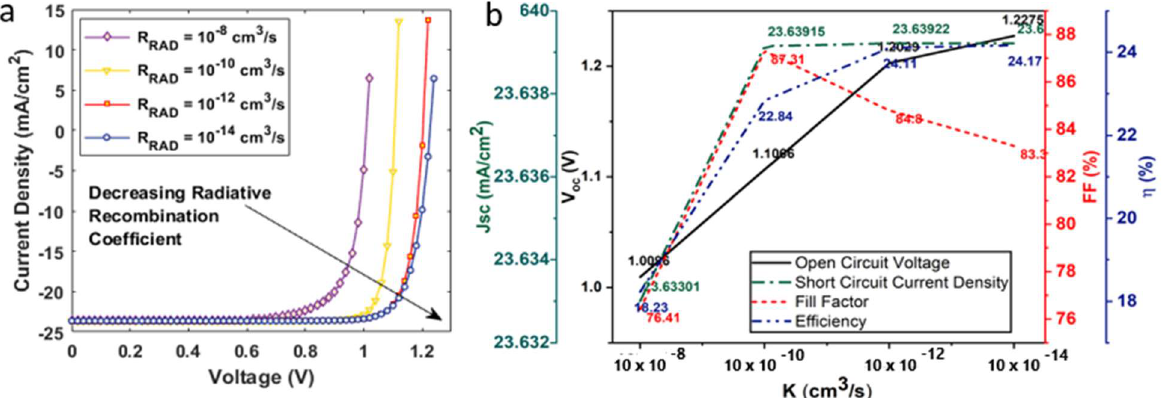
Figure 4. ( a ) Current density–voltage characteristics of a solar cell under radiative recombination; ( b ) influence of radiative recombination on the open circuit voltage, short circuit current density, fill factor, and efficiency of the solar cell.